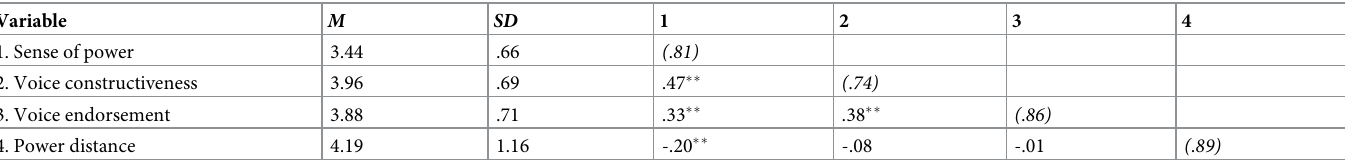
Table 1. Descriptive statistics and correlations.